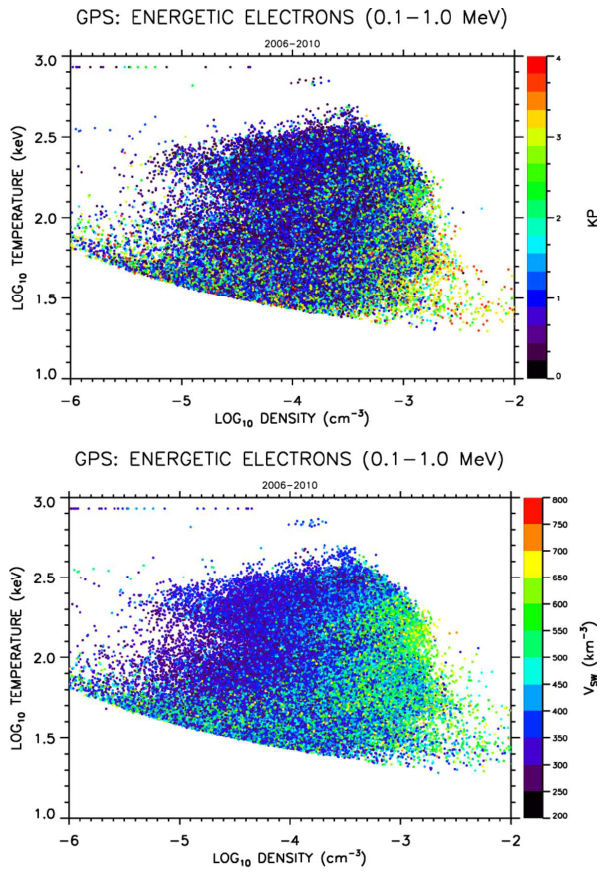
Fig. 2. Scatter plots of the derived density ( N ) and temperature ( T ) as a function of the Kp index (top panel) and the solar wind speed (bottom panel) for energetic electrons ( ∼ 0.1–1.0MeV) in the magnetotail at local times 22:00–02:00LT (151574 data points). 4 million individual data points are examined (all local times) and subsets of these data are plotted below.